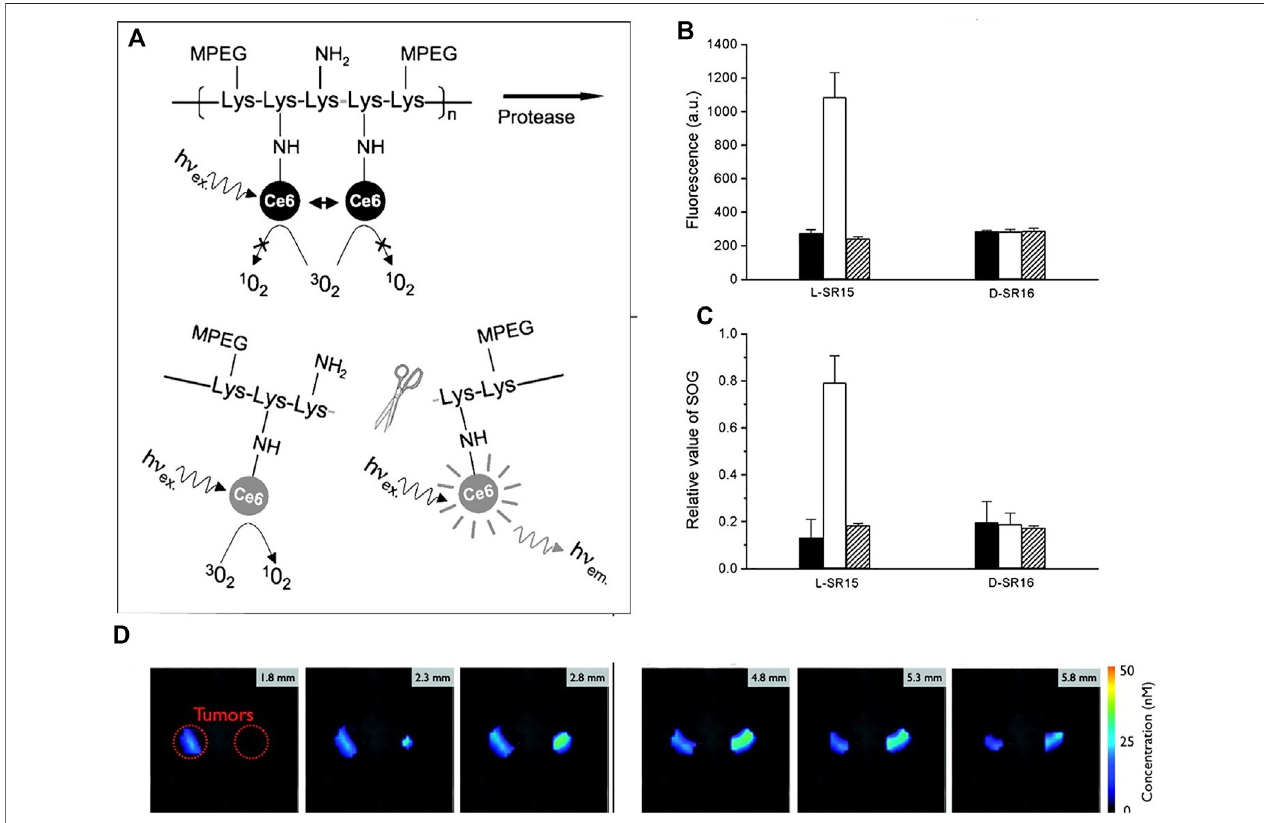
FIGURE 4 | (A) Schematic diagram of PM-PDT strategy; (B) activation of fl uorescence intensity and (C) singlet oxygen generation of L-SR15 and D-SR16 with phosphate buffer (black columns), cathepsin B (white columns), and CA-074 inhibitor-pretreated cathepsin B (striped columns); (D) six consecutive slices from a three- dimensional fl uorescence-mediated tomographic scan (Choi et al.,